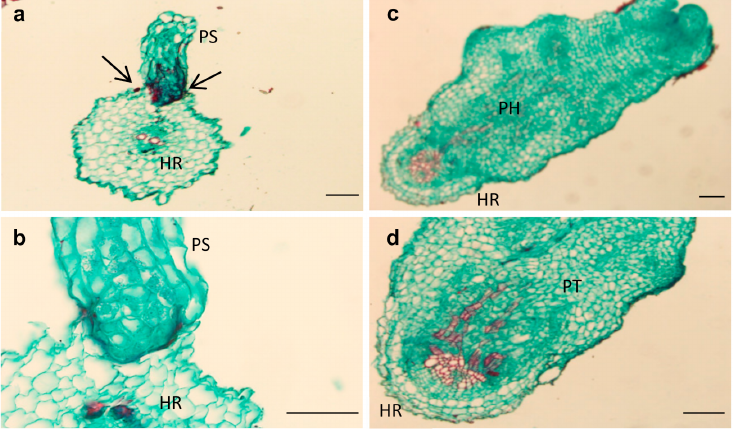
Figure 4. Cross-sections of compatible and incompatible interactions of O. cumana with resistant (‘EMEK3’) ( a , b ) and susceptible (‘D.Y.3’) ( c , d ) sunflower roots five d post-infestation. PH: parasite haustorium; HR: host root; PS: parasite seedling; PT: parasite tubercle. Scale bar = 100 µ